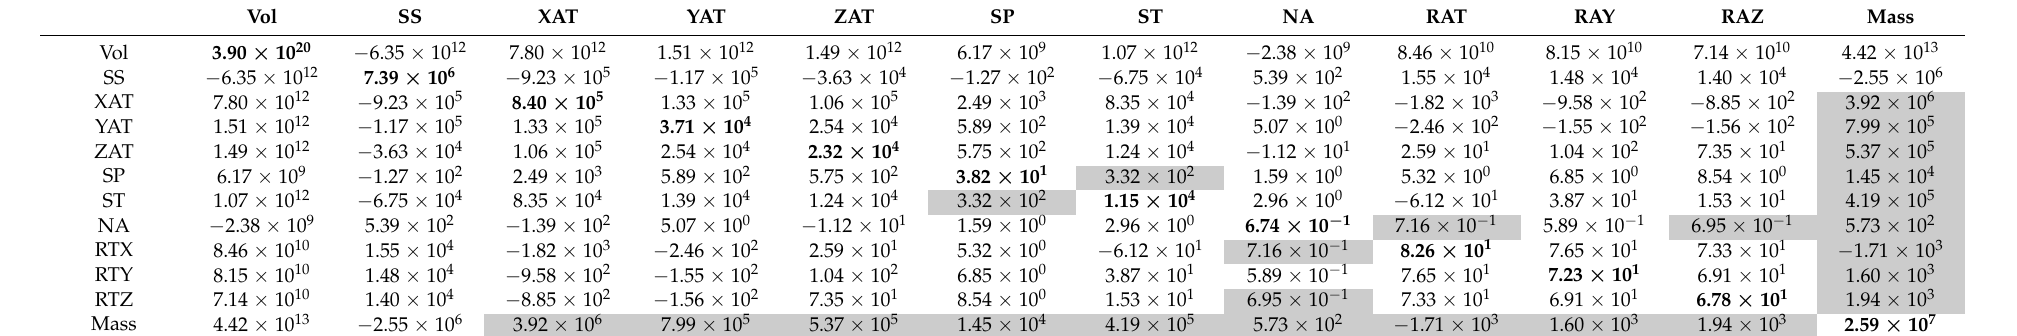
Table 4. Variance–covariance matrix for the multi-company data with the variances (across the diagonal) in bold and the significant covariances shaded (see Table 2 for